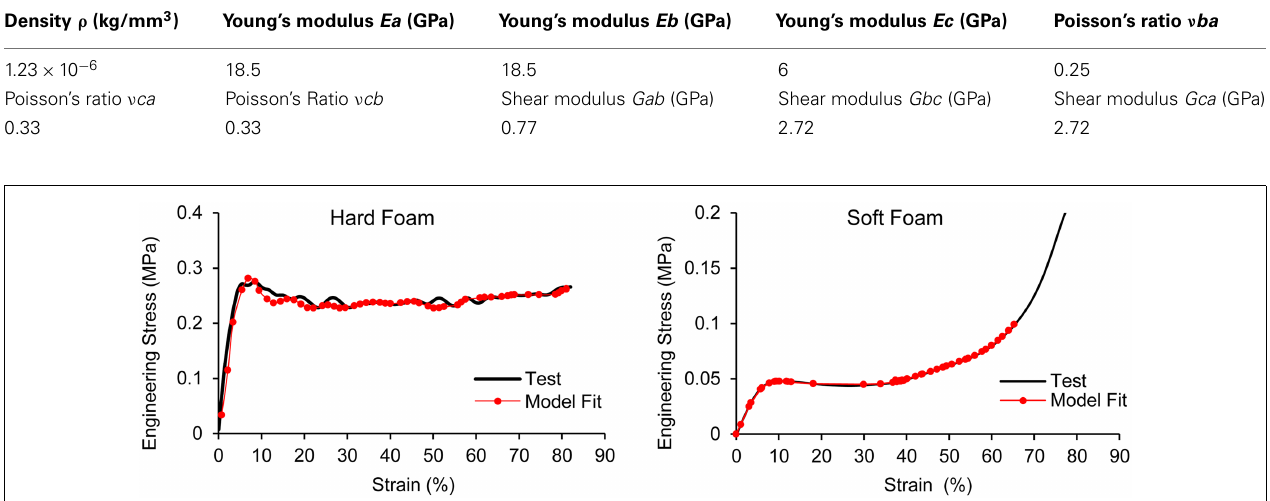
Table 1 | Material parameters defined for the shell model.